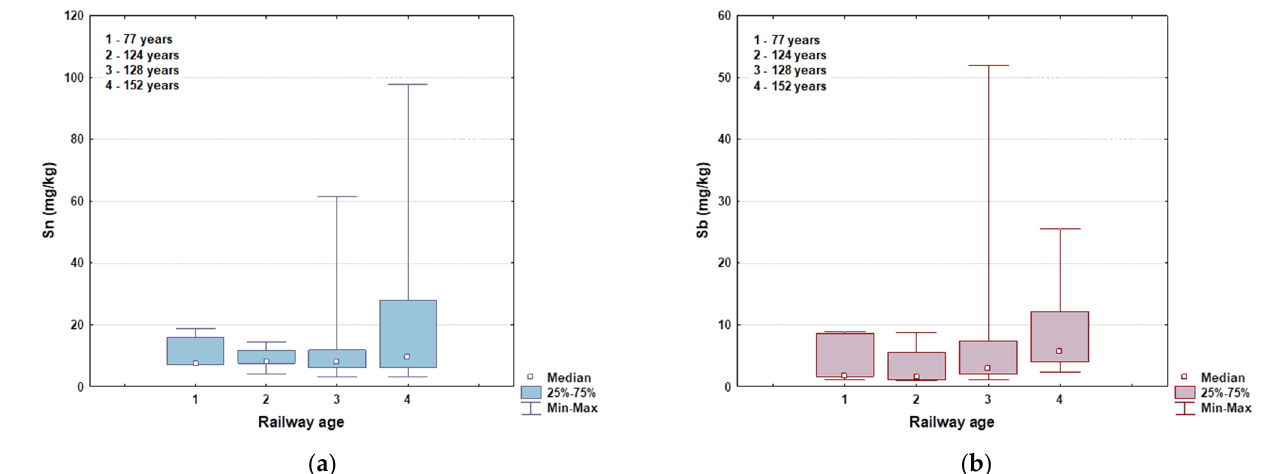
Figure 8. Dependence of concentration of Sn ( a ) and Sb ( b ) in soil and railway age (boxplots were obtained by Kruskal–Wallis ANOVA followed by a pairwise comparison using Dunn’s method, with the significance level set at p < 0.05).